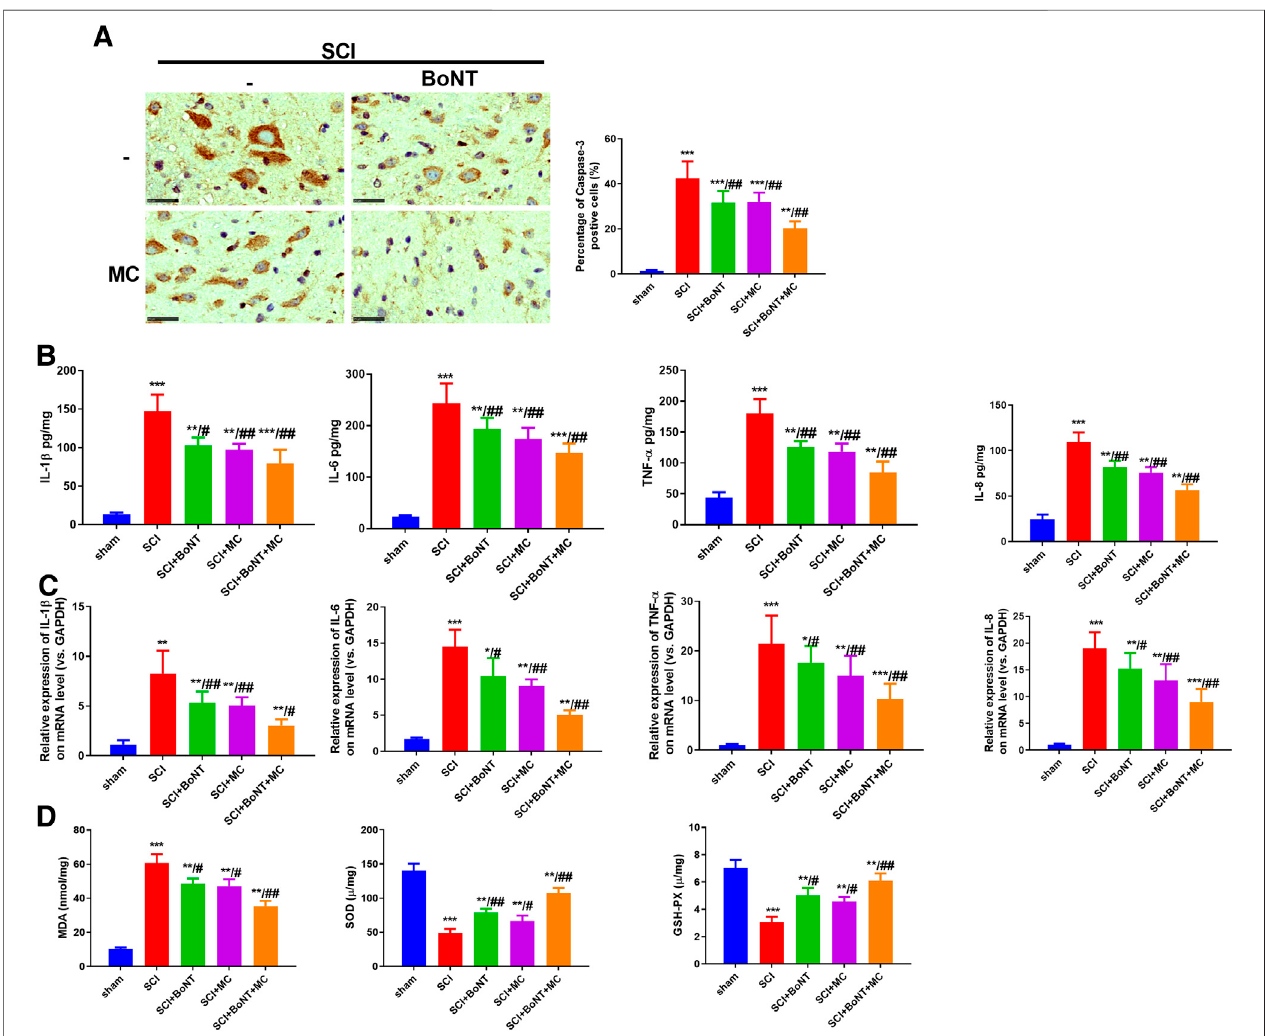
FIGURE 2 | Combination of BoNT and MC greatly reduced apoptosis, in fl ammation and oxidative stress in SCI. Cappse-3 positive cells in the surrounding tissues ofeachgroupweredetectedbyIHCin14daysafterSCI.B-CRT-qPCRandELISAwereadoptedtodetectalterationofTNF-a,IL-1 β ,IL-6,andIL-8atmRNAandprotein levels in the peripheral injury spinal cord (T9 – 10) tissues at the dorsal part in 14 days. D ELISA was used to detect the changes of MDA, SOD, GSH-PX in the injured surrounding tissues in 14 days (* p < 0.05, ** p < 0.01, *** P < p < 0.0001 V.S sham; # p < 0.05, ## p < 0.01, ### p < 0.0001 V.S SCI, N (cid:2) 5).